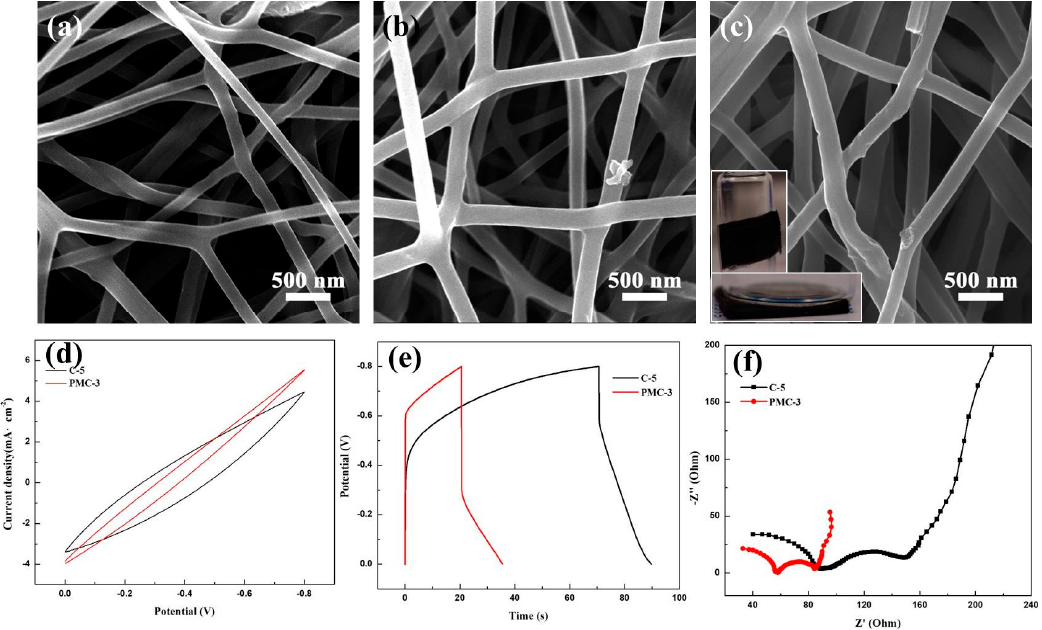
Figure 6. SEM images of the carbon nanofibers with an MWCNT mass fraction of 0.7 wt% ( a ), 1.5 wt% ( b ) and 2.4 wt% ( c ), respectively; electrochemical performance comparison of the sample C-5 and PMC-3: ( d ) CV curves at a scan rate of 5 mV/s in potential window of − 0.8~0 V; ( e ) GCD curves at the current density of 0.1 mA/cm 2 ; ( f ) Nyquist impedance spectra.